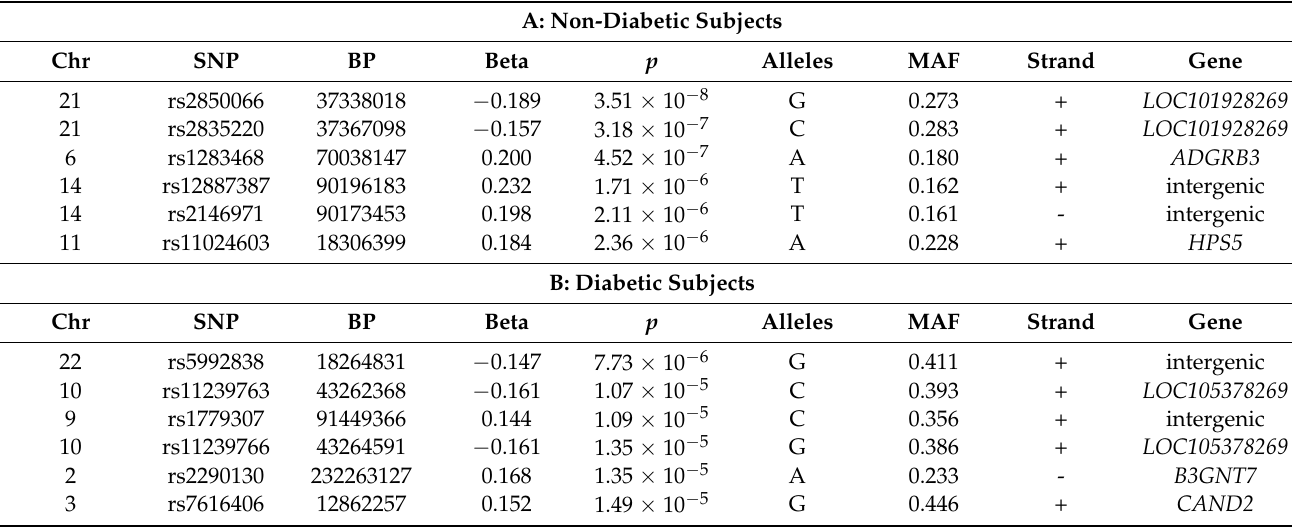
Table 6. Top-ranked SNPs of the GWAS for adiponectin concentrations (ln-transformed) in non-diabetic and diabetic subjects.